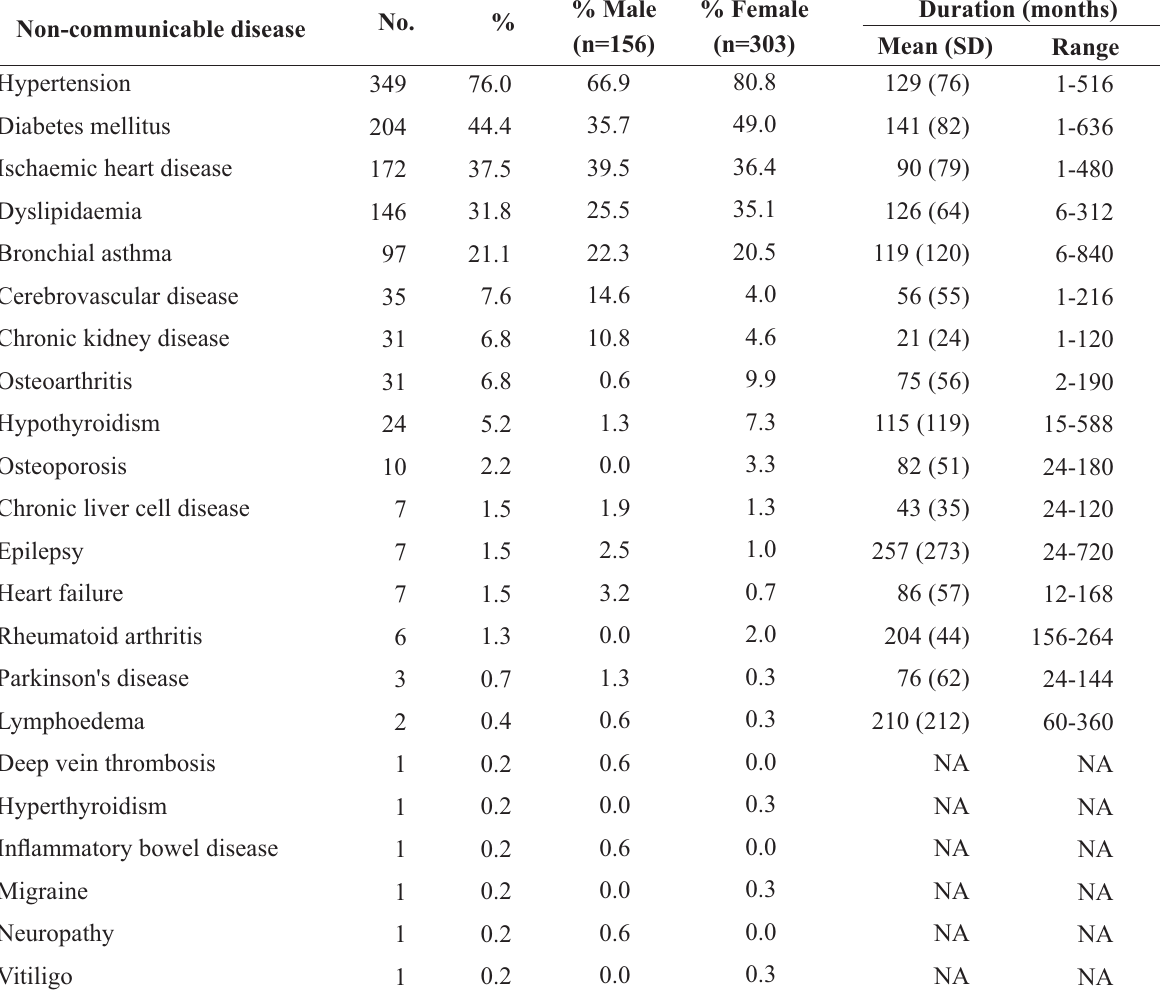
Table 1: Non-communicable diseases among the study participants (N=459) Non-communicable